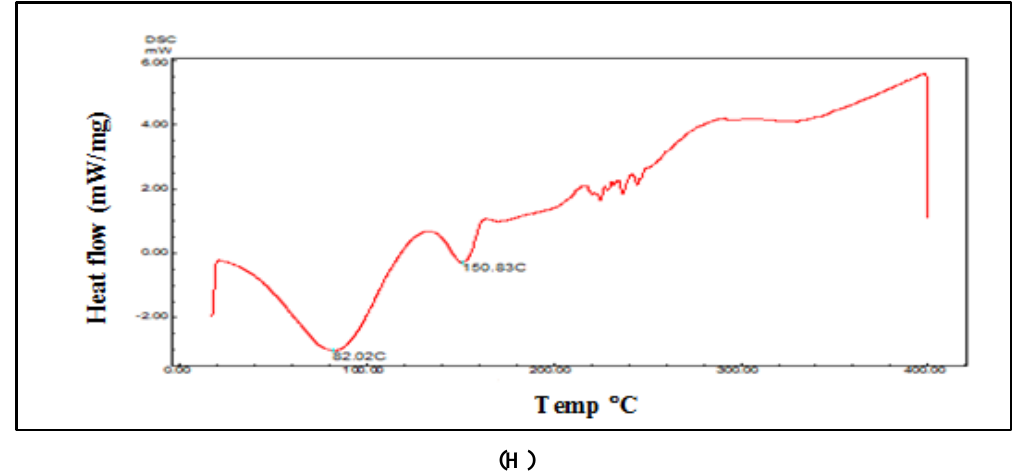
Figure (2) DSC thermogram of SM (A), gelatin (B), MC9 (C), MC1 (D), MC10 (E), MC9s (F), MC1s (G), MC10s (H).